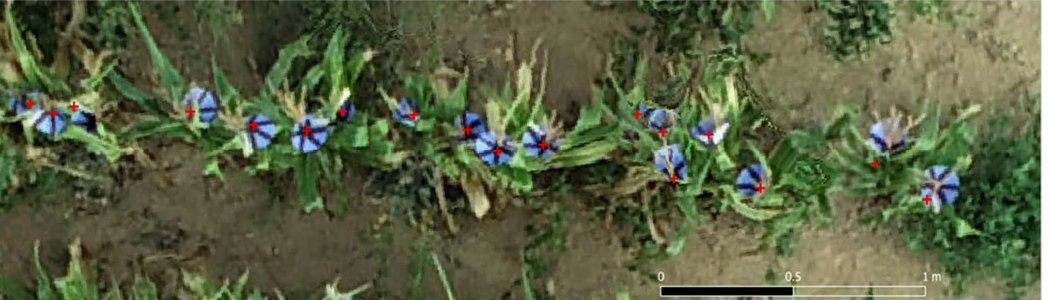
Figure 28. Final ortho-mosaic of R_1 reconstruction, visualized in the QGIS software, zoom on the second maize row, with in overlay the plant positions, measured on the ground with Geo7x DGNSS in pole mode ( + ).